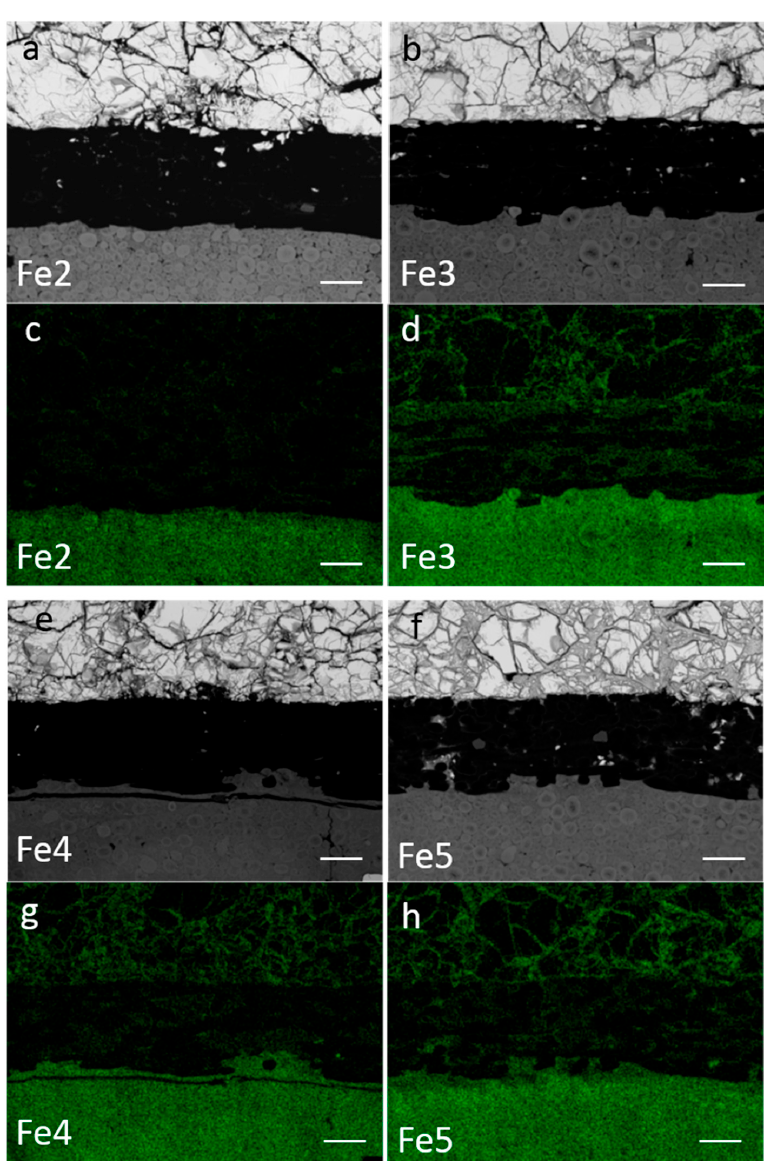
Figure 10. SEM micrographs of the cross-sections of cells ( a ) Fe2, ( b ) Fe3, ( e ) Fe4, and ( f ) Fe5 and their corresponding O-EDS elemental mappings of cells ( c ) Fe2, ( d ) Fe3, ( g ) Fe4 and ( h ) Fe5 after cycle life testing at 50 °C. The scale bar represents 50 µm. In each figure, the sandwich structure from top to bottom consists of the negative electrode, separator and positive electrode.